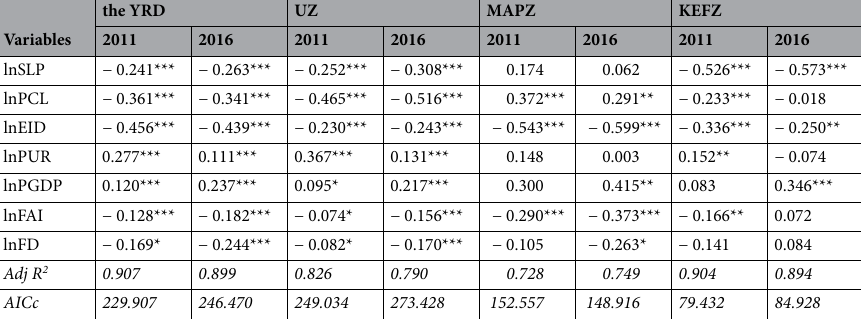
Table 6. The statistical description of MGWR sub-model.